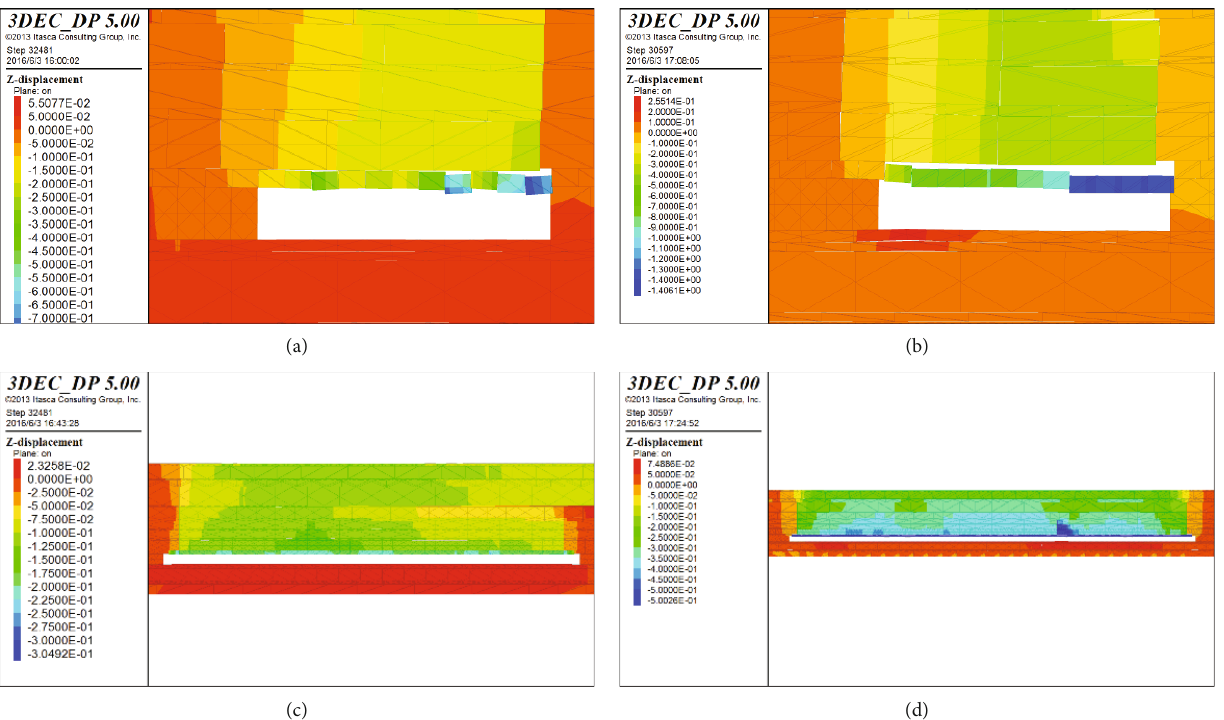
Figure 5: Nephogram of roof strata displacement when advancing to 32.5m(unit: m): (a) slice of the 195m working face in advancing direction, (b) slice of the 376m working face in advancing direction, (c) lengthwise slice of the 195m working face, and (d) lengthwise slice of the 376m working